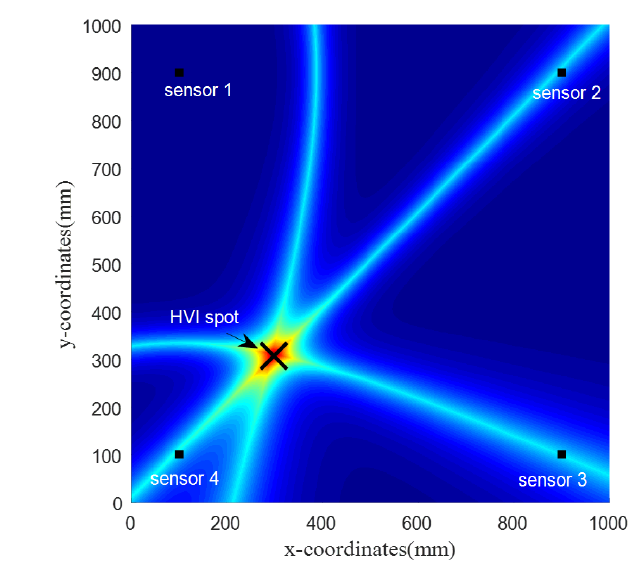
Figure 13. The probabilistic results of the impact location estimate for validation.